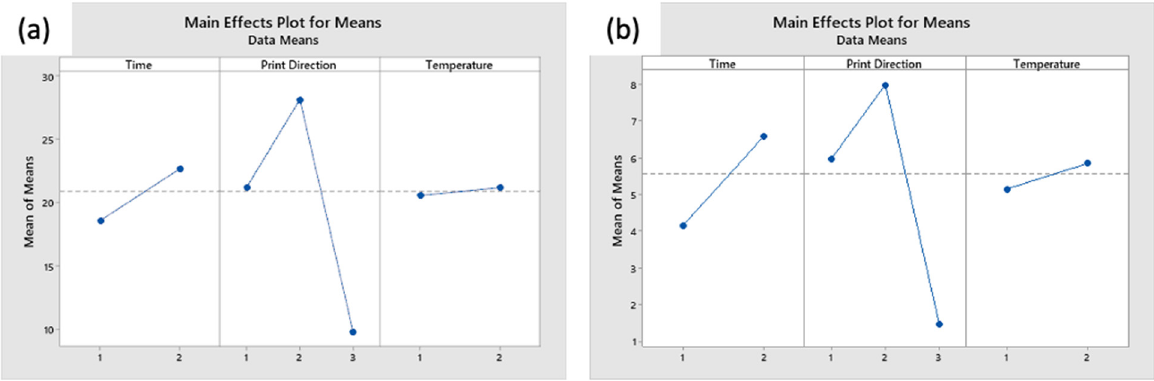
Figure 10. Effect plot for change post annealing: ( a ) Ultimate Tensile Strength and ( b ) Strain at Break.